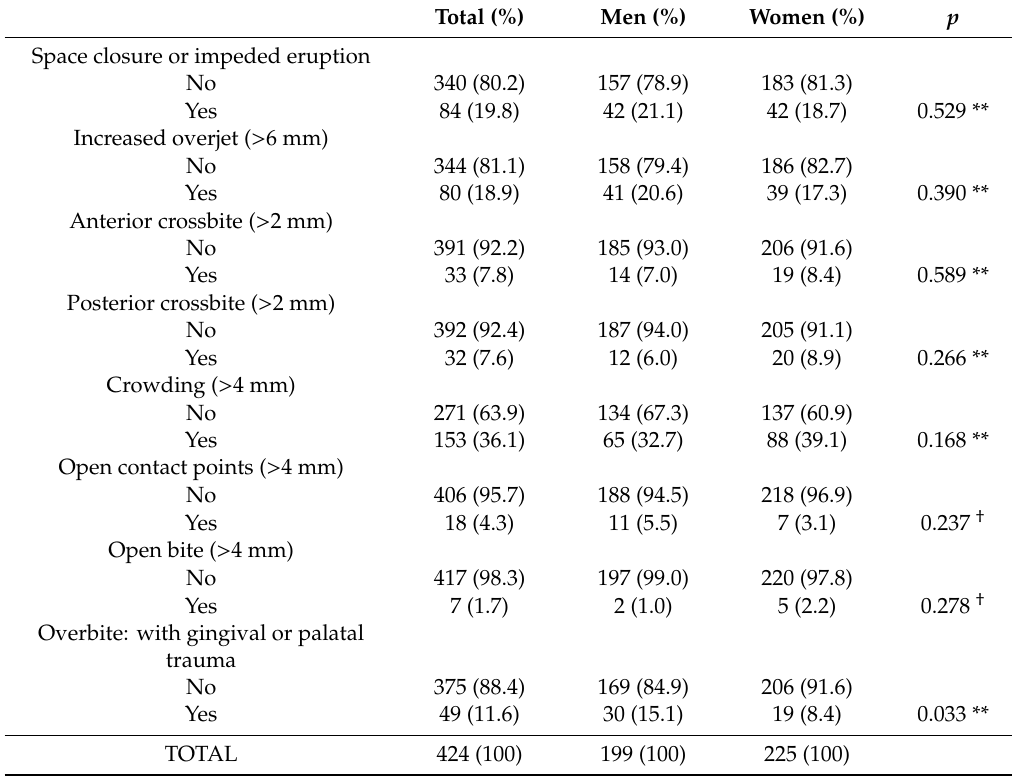
Table 1. Prevalence of occlusal anomalies * by the sex of the population studied.